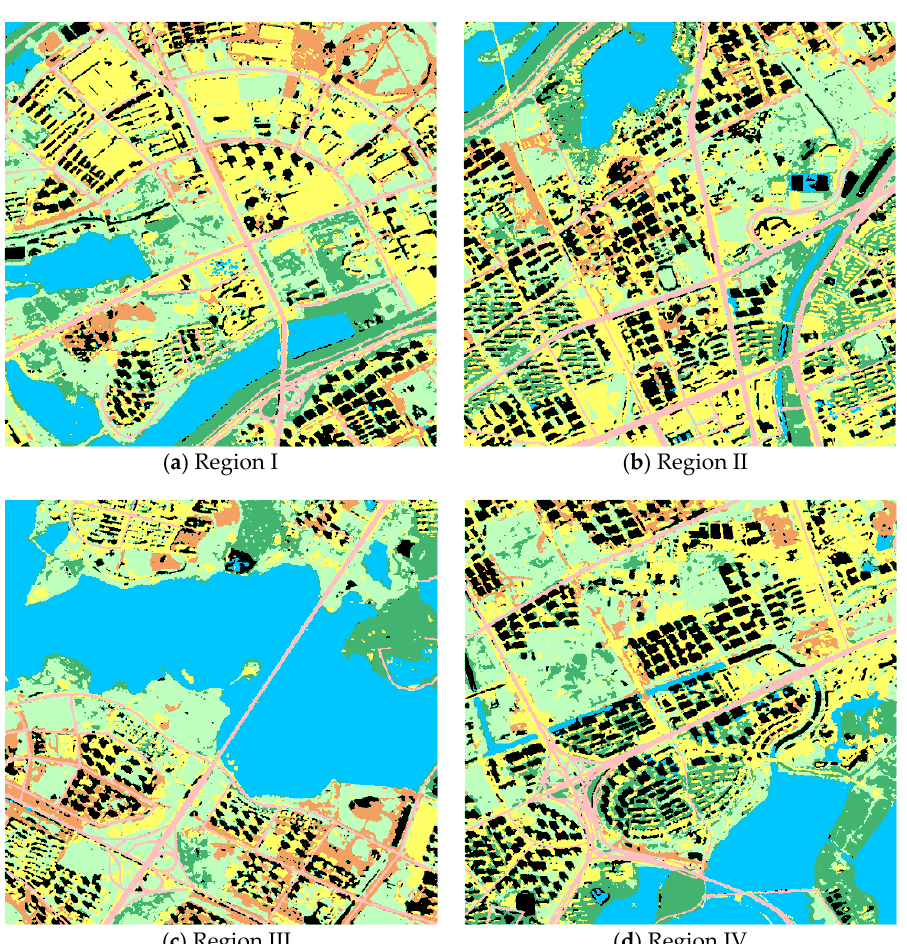
Figure 4. Classification maps of the four test regions provided by the proposed method (yellow =